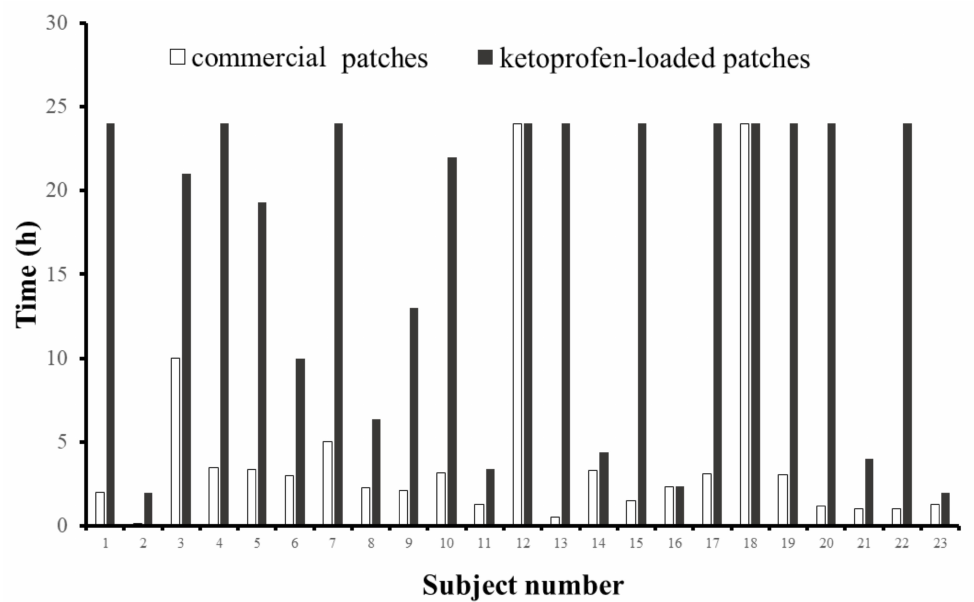
Figure 9. Fall-off time of the drug-loaded patches, compared with the commercial patches, in twenty-three